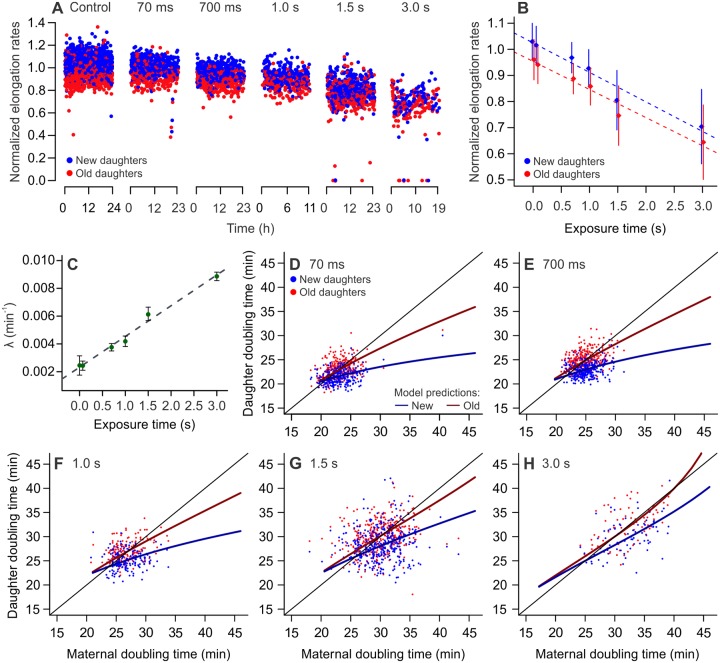
Damage accumulation decreases elongation rates and displaces growth equilibrium.All panels depict MG1655 wild-type E. coli. (A) Exposure to phototoxic damage led to decreasing elongation rates in all treatment levels (length of exposure, every 2 min: 70 ms, 700 ms, 1 s, 1.5 s, 3 s). (B) Both new and old daughters displayed slower growth in response to phototoxic damage (F = 9,272, p < 0.001), with new daughters growing faster than their old siblings in all cases (F = 1,505, p < 0.001). There was significant interaction between age and damage level in determining elongation rates (F = 2,384, p < 0.001; two-way ANCOVA). Data are represented as mean ± SD (S7 Data). (C) Linear correlation between length of phototoxic damage exposure and damage accumulation rates estimated for each treatment (p < 0.001, R2 = 0.98). Data are represented as mean ± 95% CI. (D to H) Distinct subpopulations of young and old daughters were observed in all treatment levels, with increasingly longer doubling time equilibria (S4 Data). At 3 s of exposure (λ = 0.009 min−1), the old lineages lie at the threshold of arresting proliferation.